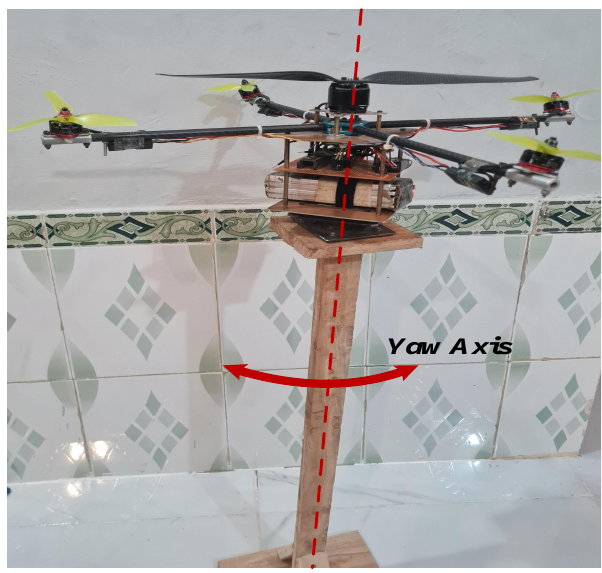
Figure 8. Test rig for yaw